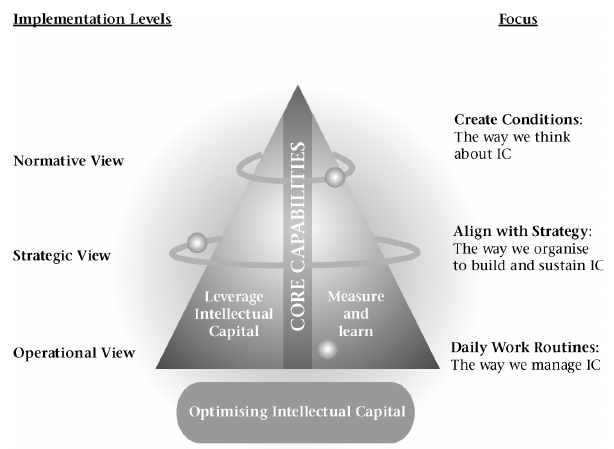
Figure 3: Intellectual Capital Framework as part of the Conceptual Model.